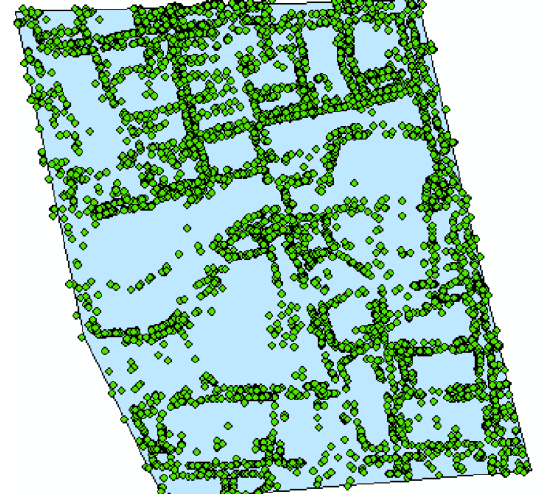
Figure 1 . Figure test geographical